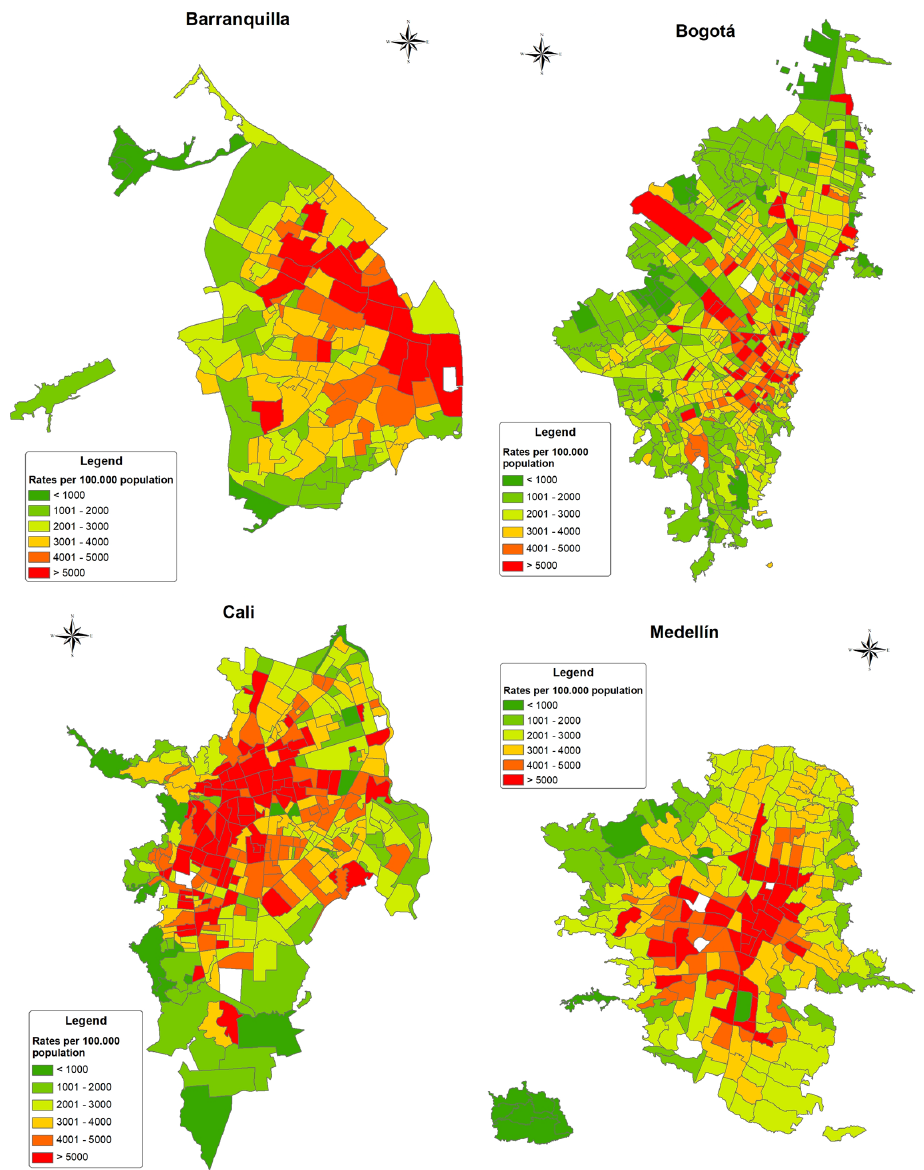
Figure 1. Bayesian mortality rates for all deaths by city in Colombia 2015–2019.